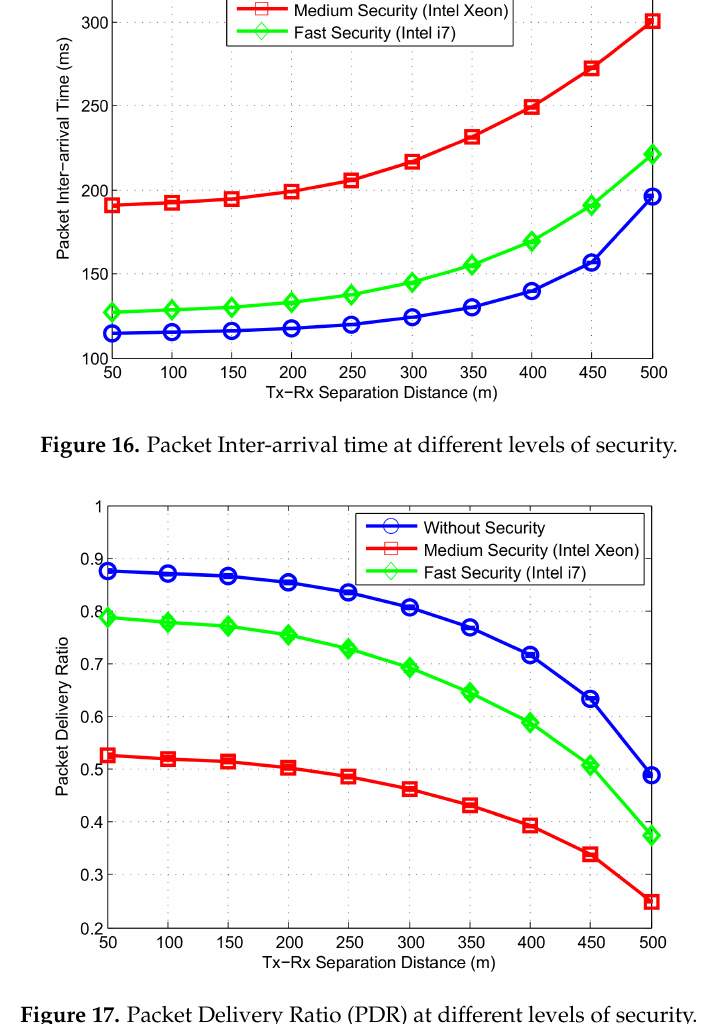
Figure 17. Packet Delivery Ratio (PDR) at different levels of